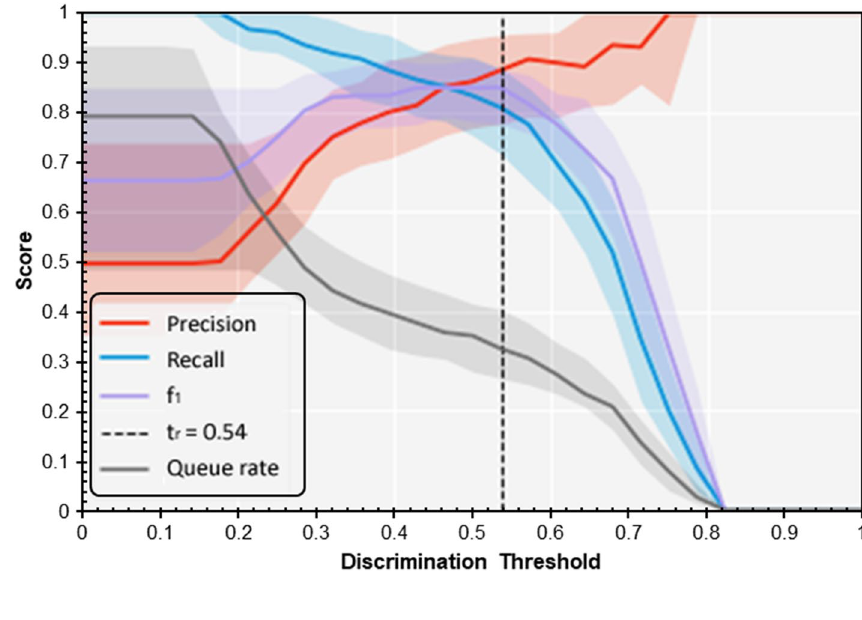
Fig. 4 Discrimination threshold of ensemble model Light- GBM + k -NN + Adaboost